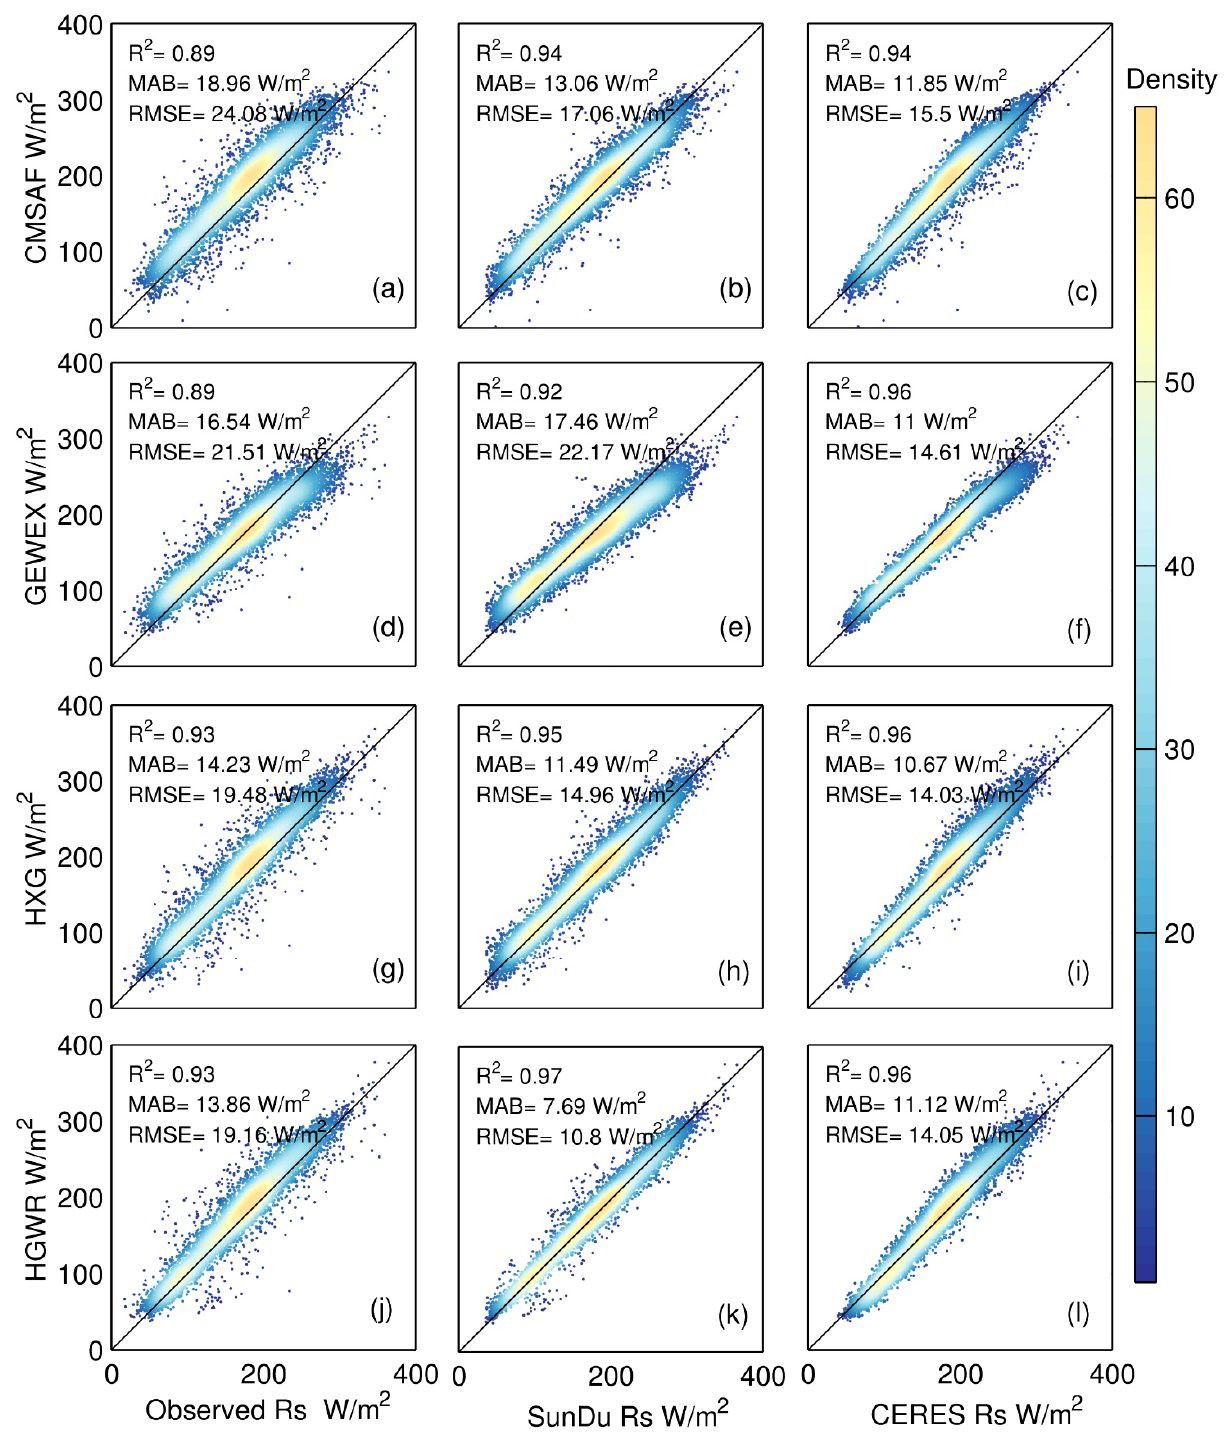
Figure 2. Comparison of monthly surface solar radiation ( R s ) from the Climate Monitoring Satellite Application Facility (CMSAF)cloud and radiation data record (CLARA-A2) (CMSAF), Global Energy and Water Exchanges-surface radiation budget (GEWEX-SRB) (GEWEX), International Satellite Cloud Climatology Project ISCCP H-series cloud product HXG (ISCCP-HXG)-based R s data (HXG) and the merged product (HGWR) by using different validation data from 2000 to 2007. Subplots ( a , d , g , j ) represent validation results using direct observations, while ( b , e , h , k ) represent SunDu-derived R s data (SunDu R s ), and subplots ( c , f , i , l ) represent Clouds and the Earth’s Radiant Energy System energy balanced and filled product (CERES EBAF) data